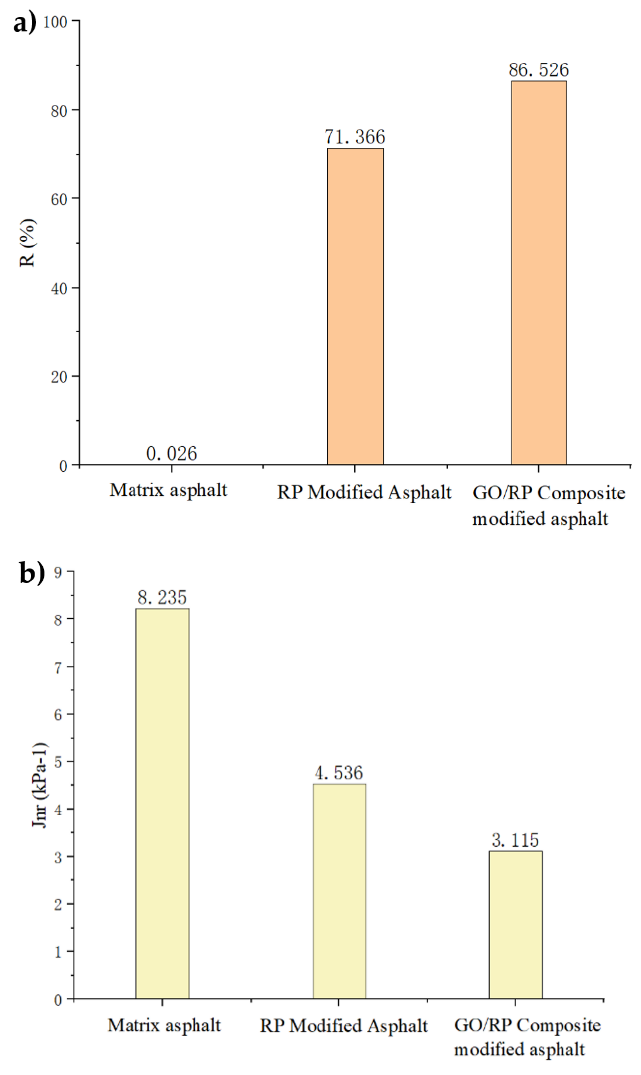
Figure 7. Asphalt recovery ability test results: ( a ) creep recovery rate r of different asphalt at 0.1 kPa; ( b ) unrecoverable creep compliance J nr of 0.1 kPa different asphalt.